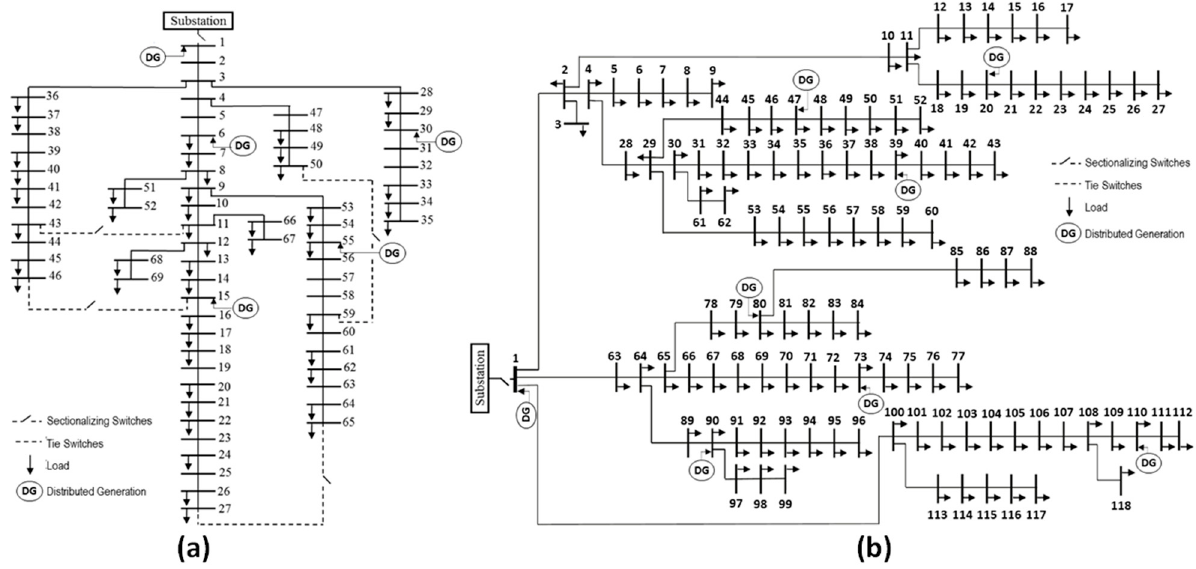
Figure 7. Modified microgrid single line diagram: ( a ) IEEE 69-bus; ( b ) IEEE 118-bus. System data were adopted from [60] for the 69- and 118-bus systems. Moreover, the two systems had identical DG units connected to buses given in Table 2 and depicted in